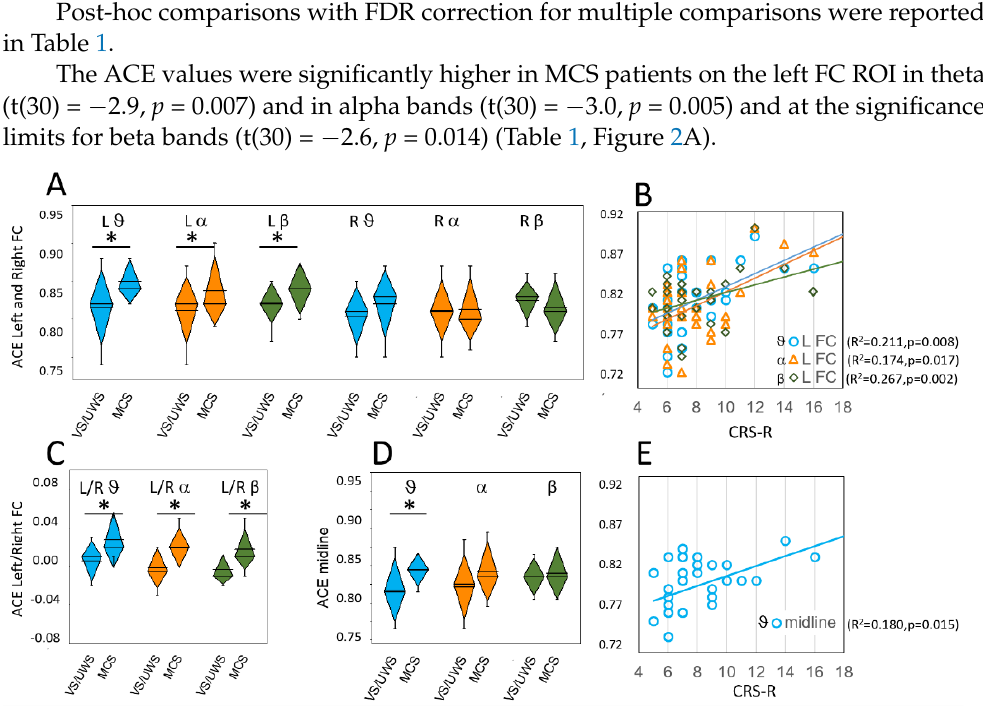
Figure 2. ACE values on left (L) and right (R) fronto-central ( A ); and midline ( D ) regions. Panels ( C ) shows the ratio between measures on left and right fronto-central regions; Panel ( B ) shows the linear relationships between ACE values obtained on the left fronto-central region and CRS-R values; Panel ( E ) shows the linear relationship between ACE values on the midline region and CRS-R values. Values and lines that did not give significant relationships are not shown. Colors and symbols as in Figure 1. Significant differences are marked with